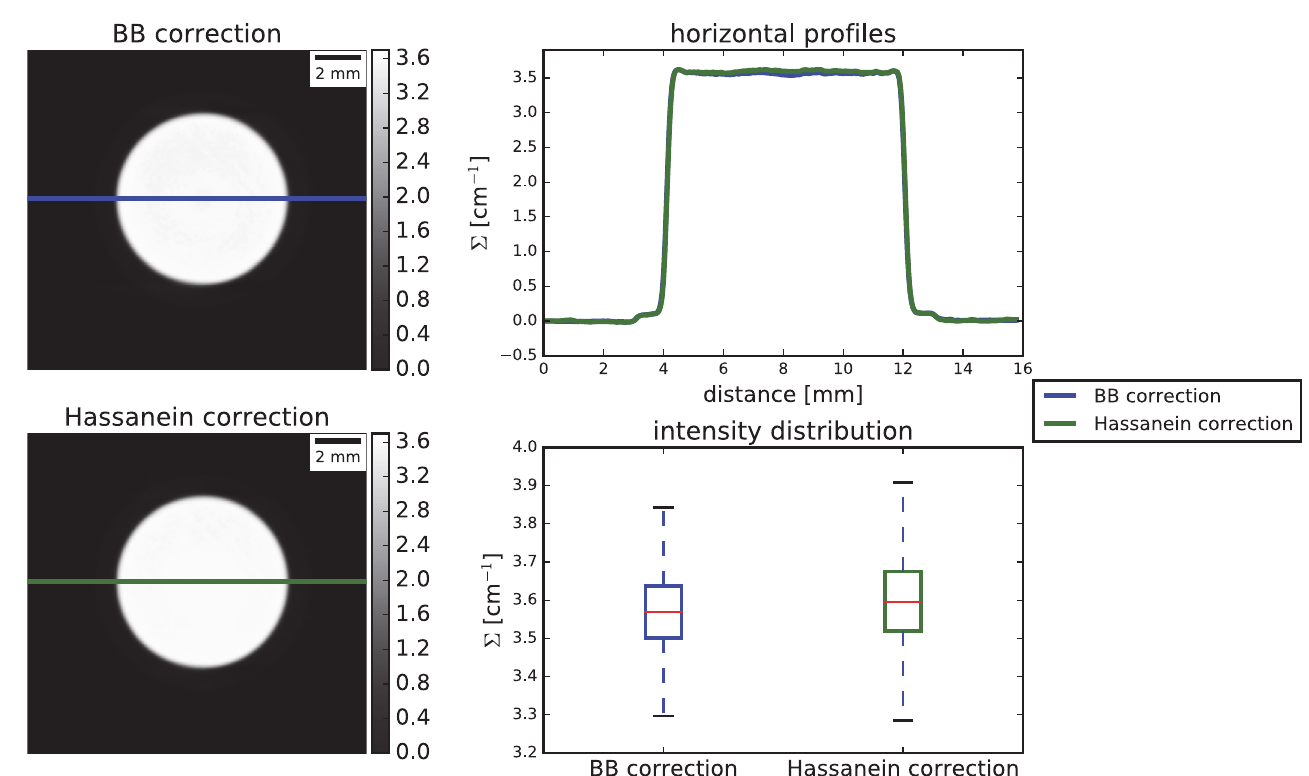
Fig 6. Comparison between the BB correction and the method proposed by Hassanein [27] for the water sample.